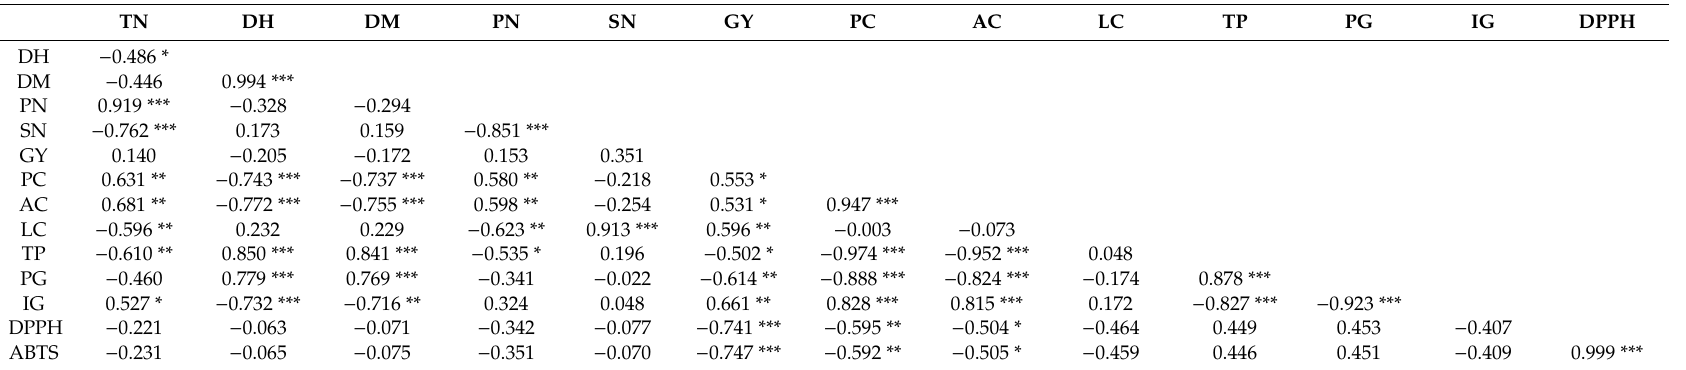
Table 7. The correlation coe ffi cient of growth parameters, grain yield and its components with quality traits and antioxidant activities among exotic rice